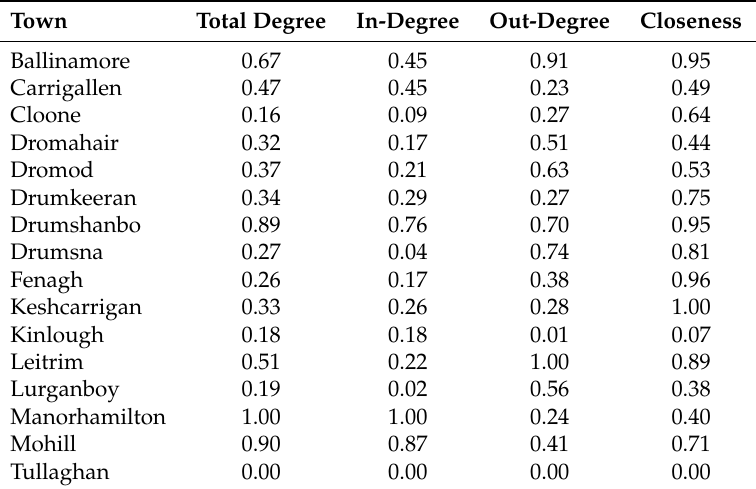
Table 7. Normalized centrality by